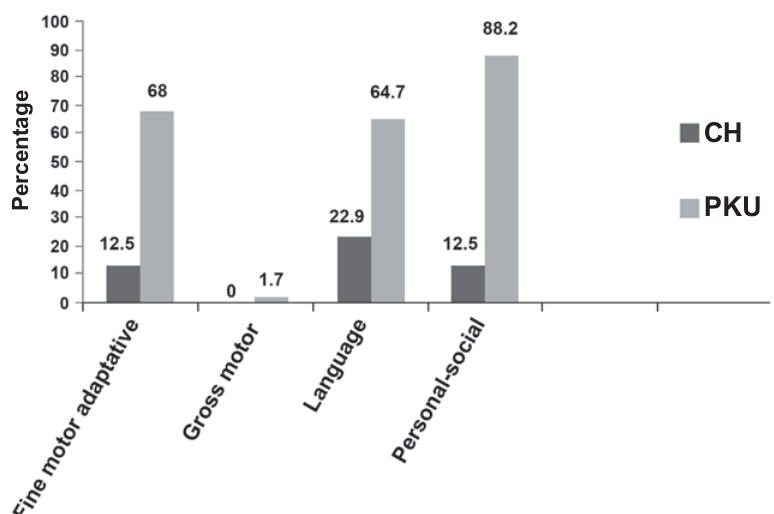
Figure 1- Percentage of children with alterations in the abilities of the